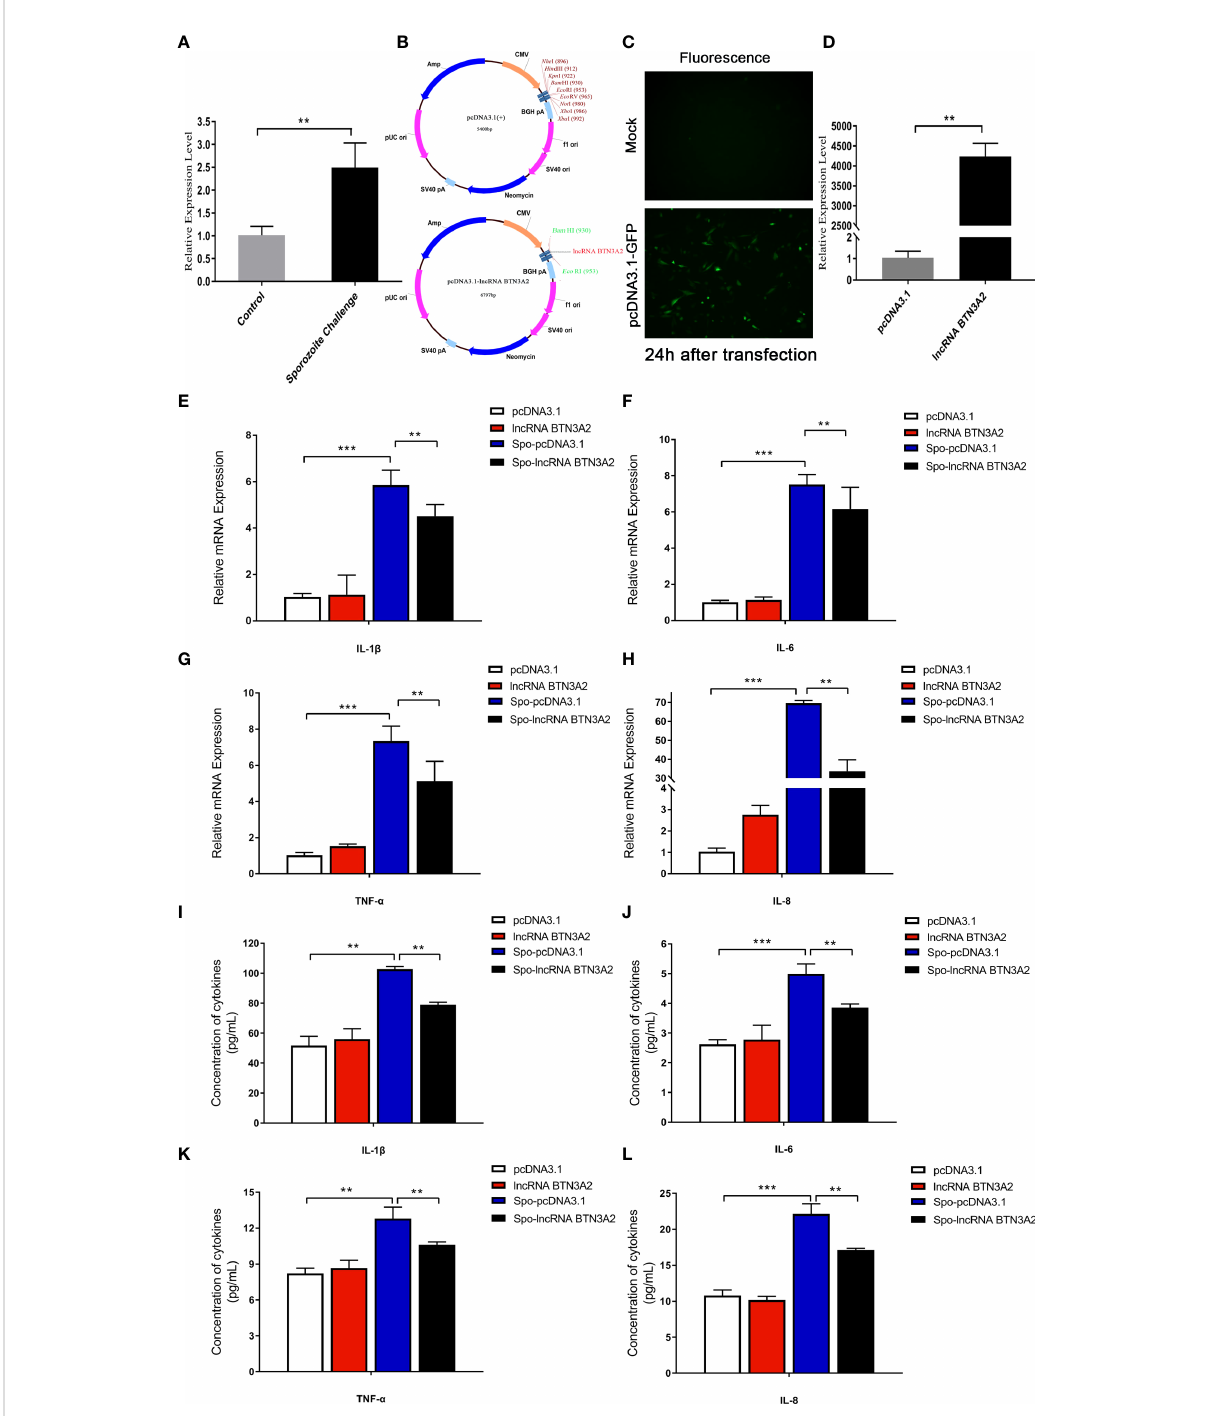
FIGURE 8 LncRNA BTN3A2 inhibits the production of in fl ammatory cytokines in sporozoite-stimulated DF-1 cells. (A) Expression of lncRNA BTN3A2 in blank and sporozoite-stimulated DF-1 cells. (B – D) Plasmid information (B, C) and overexpression effect (D) of lncRNA BTN3A2 after transfected DF-1 cells for 24 h (E – H) After 24 h of transfection, the cells were stimulated with sporozoite for another 6 h, and the mRNA expression levels of IL-1 b (E) , IL-6 (F) , TNF- a (G) and IL-8 (H) were analyzed by qRT – PCR and normalized to b -actin. (I – L) After 24 h of transfection, the cells were stimulated with sporozoite for another 6 h, and the production of IL-1 b (I) , IL-6 (J) , TNF- a (K) and IL-8 (L) in the supernatant of DF-1 cells was demonstrated by ELISA. * P < 0.05, ** P < 0.01, and *** P <